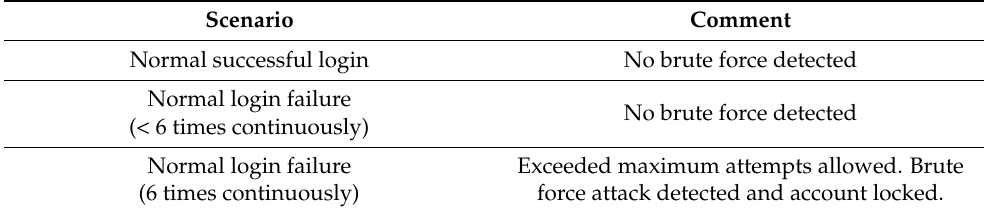
Table 10. Brute force attack’s unit testing with